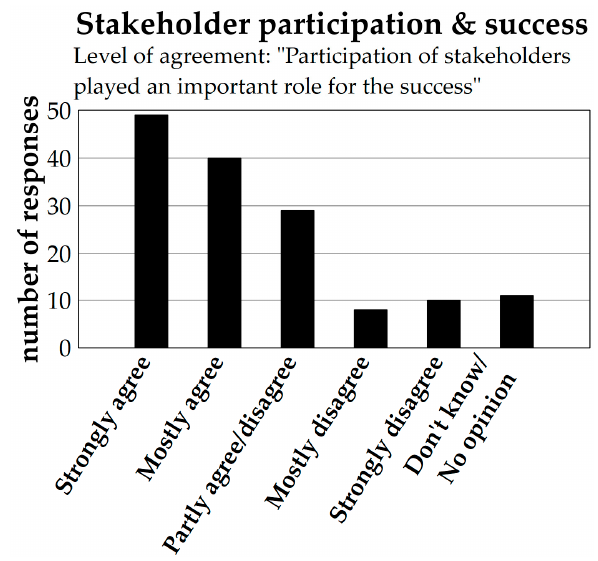
Figure 7. Role of stakeholder participation for project success.